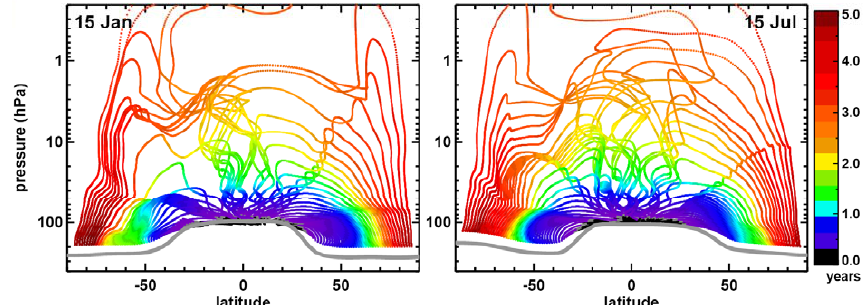
Fig. 2. Trajectories along time-dependent annually repeating residual streamlines and their associated transit times (colour coding, years) for CMAM. Trajectories were run backward starting at arrival latitudes poleward of 30 ◦ on 15 January (left) and 15 July (right) and were terminated when they crossed the tropopause. Arrival pressure is set to correspond to 2 lines mark average tropopause pressure for given